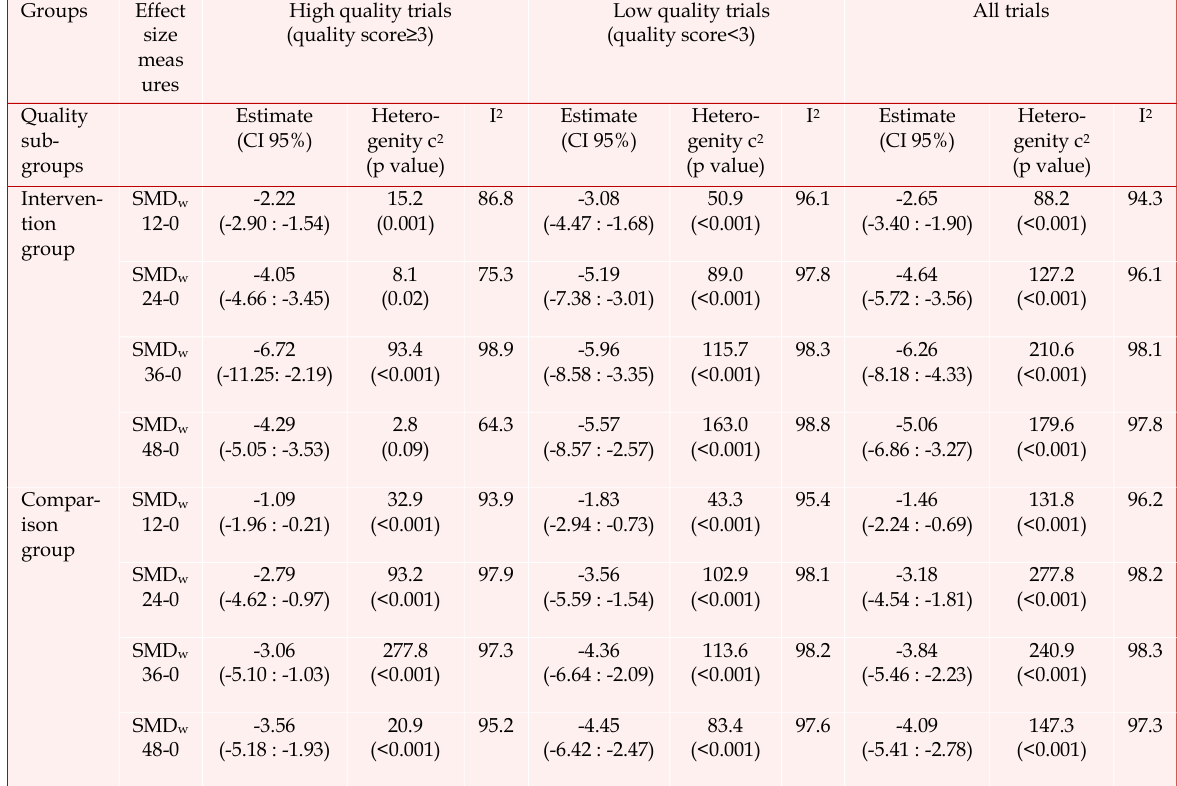
Subgroup analysis in according to methodological quality and by two arms (intervention versus comparison)